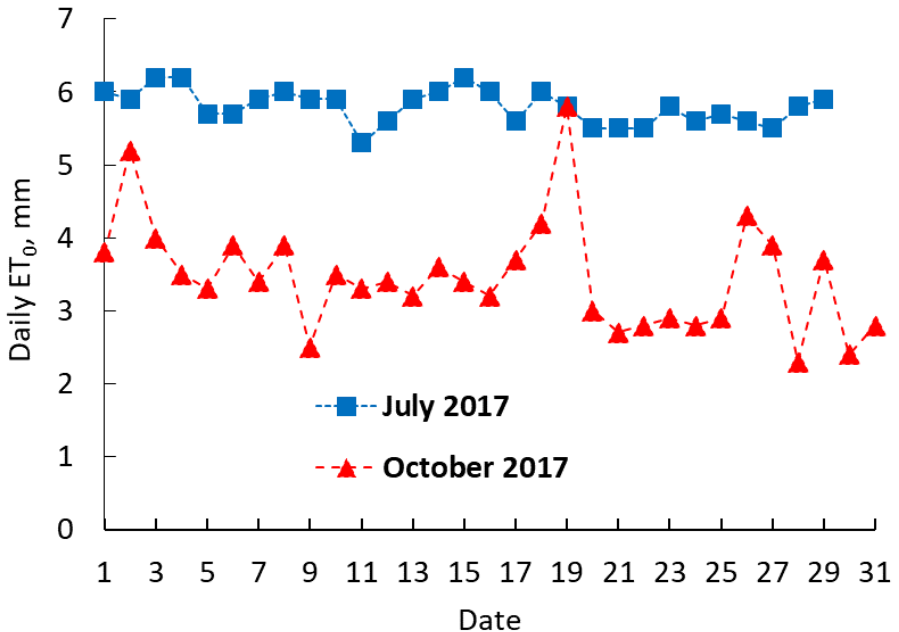
Figure 9. Monthly variation of the daily reference evapotranspiration, ET 0 , estimated in a standard meteorological station, about 6 km away from the banana screenhouse.